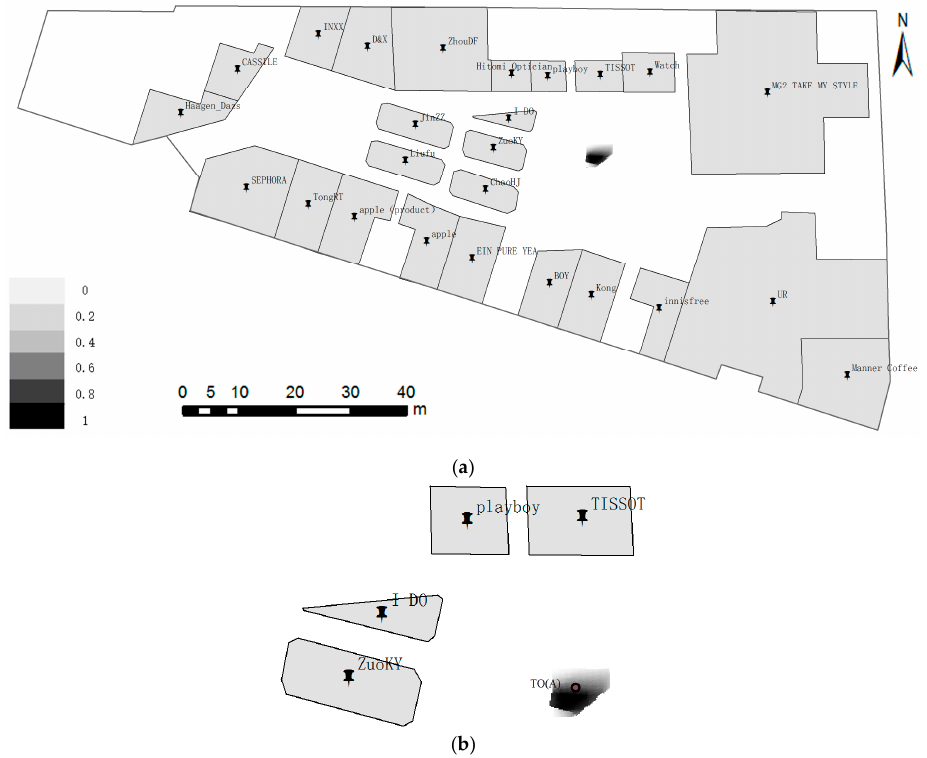
Figure 13. Positioning with two ROs at point TO(A) approximately 15.5 m away from TISSOT. The locality description is “front 20 m is TISSOT, and left 15 m is ZuoKY.” ( a ) Global; and ( b ) Local.